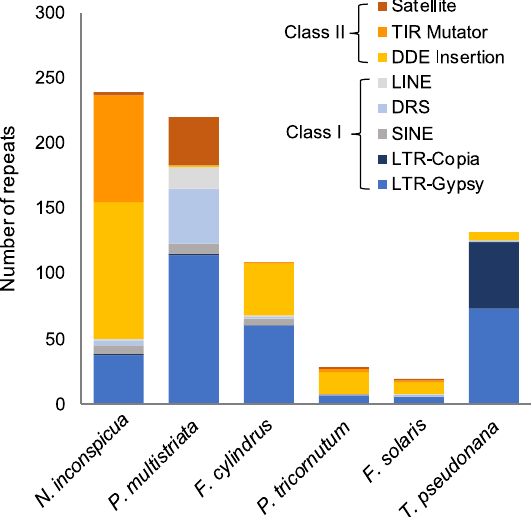
Figure 4. Repetitive element types in N. inconspicua versus other diatom genomes. Class designations refer to copy and paste (Class I) versus cut and paste (Class II) transposon replication mechanisms. Total numbers represent estimated haploid frequencies, so N. inconspicua totals have been divided by